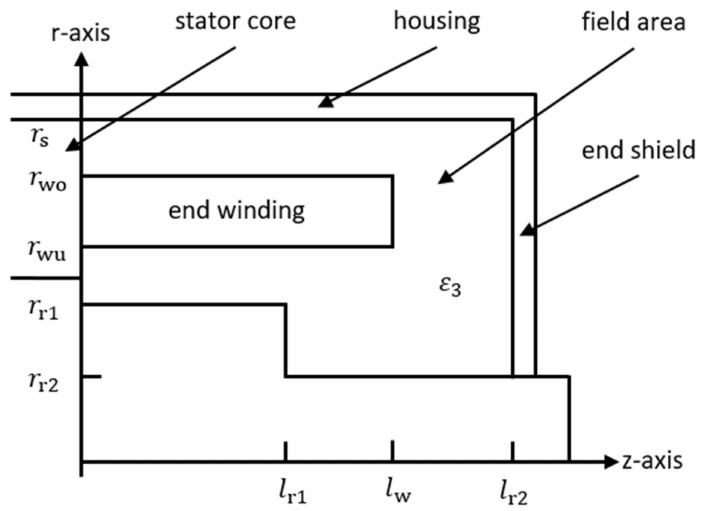
Figure 3. Representation of the end-winding model.